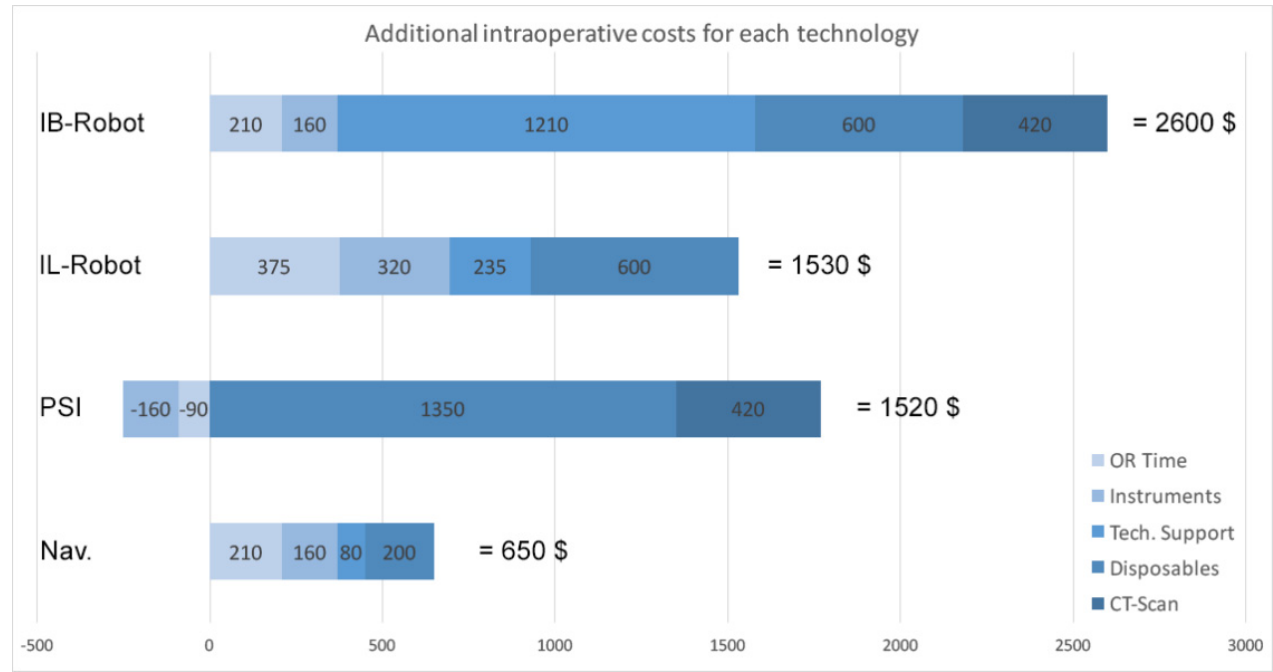
Figure 1. Graphic representation of the extra costs for each investigated technology used to implant a TKA, as compared to conventional standard procedure. The numbers indicate the different values in US-dollars per cost